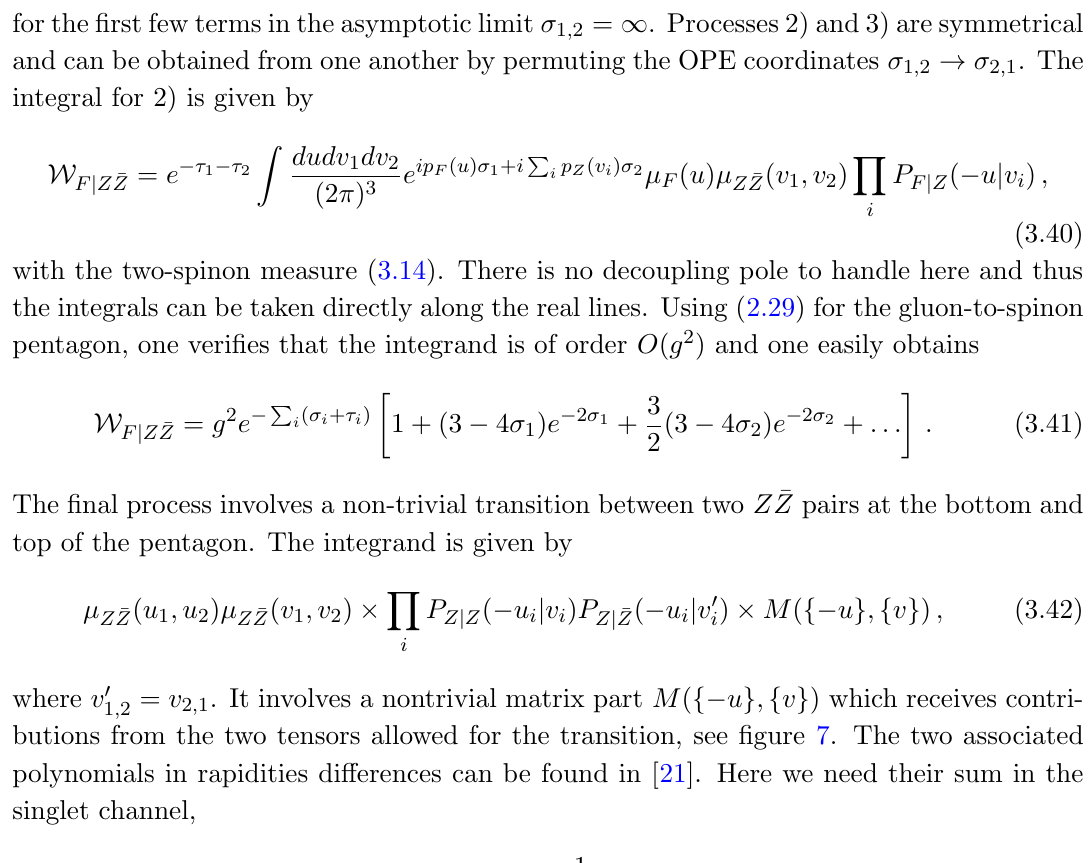
(cid:14) B + (cid:25) 2 (cid:14) B (cid:14) C . A D A D = 1 . Processes 2) and 3) are 1 ; 2